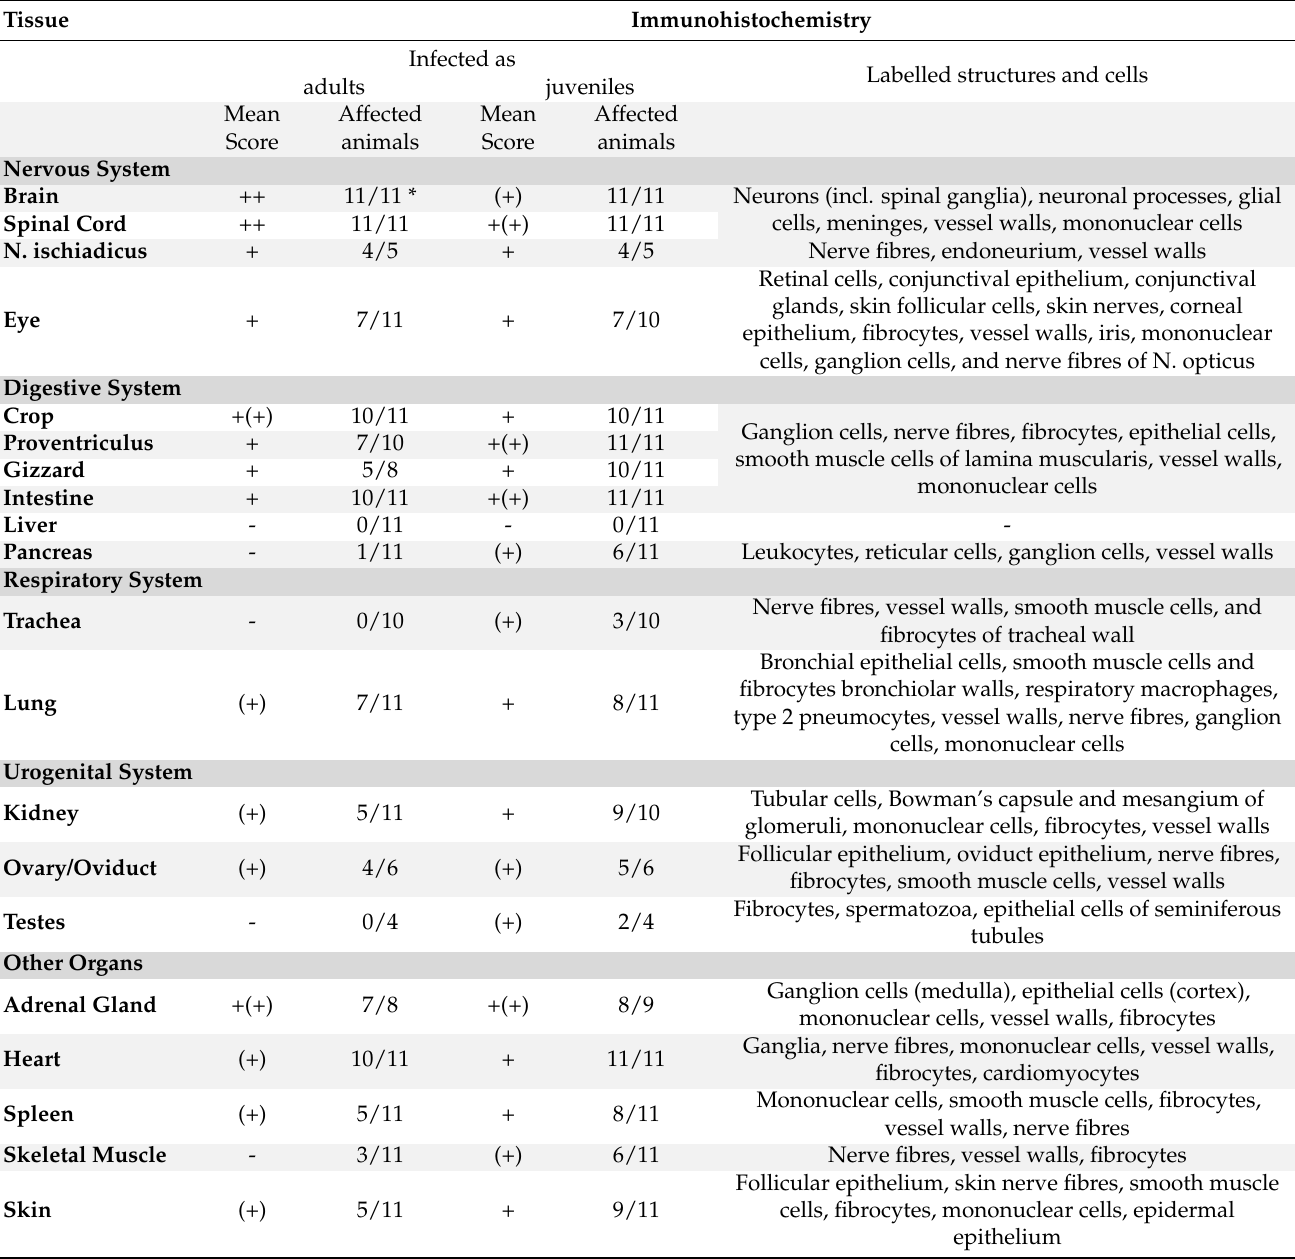
Table 3. Overview of immunohistochemical results of organs and cell types of 11 adult- and 11 juvenile-PaBV-4 infected